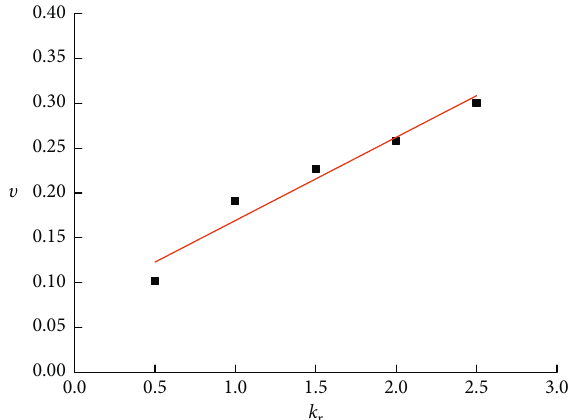
Figure 11: The relationship between Poisson’s ratio and the stiffness